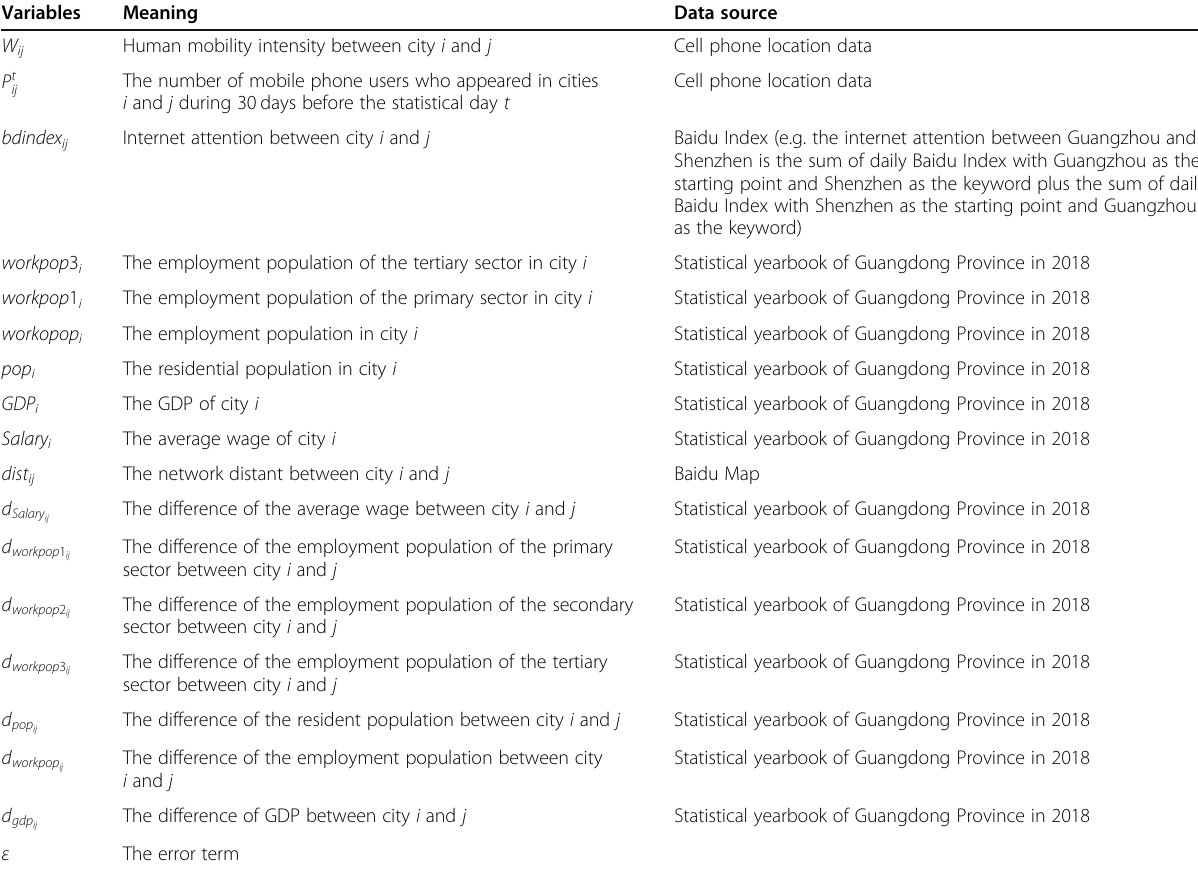
Table 1 Introduction to the data for modeling